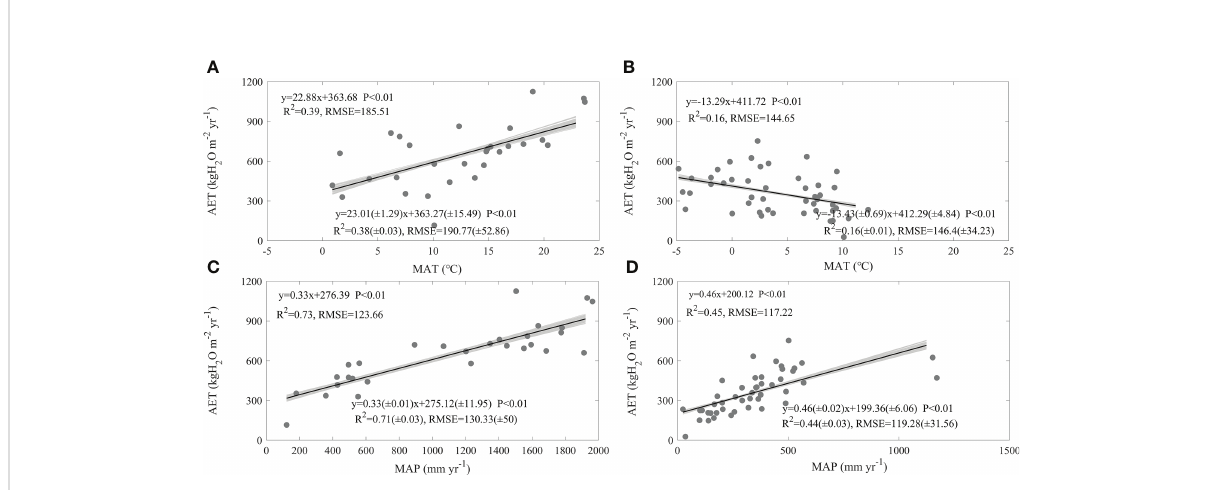
FIGURE 4 Effects of mean annual air temperature (MAT, A, B ) and mean precipitation (MAP, C, D ) on the spatial variations of annual evapotranspiration (AET) in forests (A, C) and grasslands (B, D) in China. The grey lines are regression lines generated from the random error adding AET, whose statistics are presented in the right bottom of each